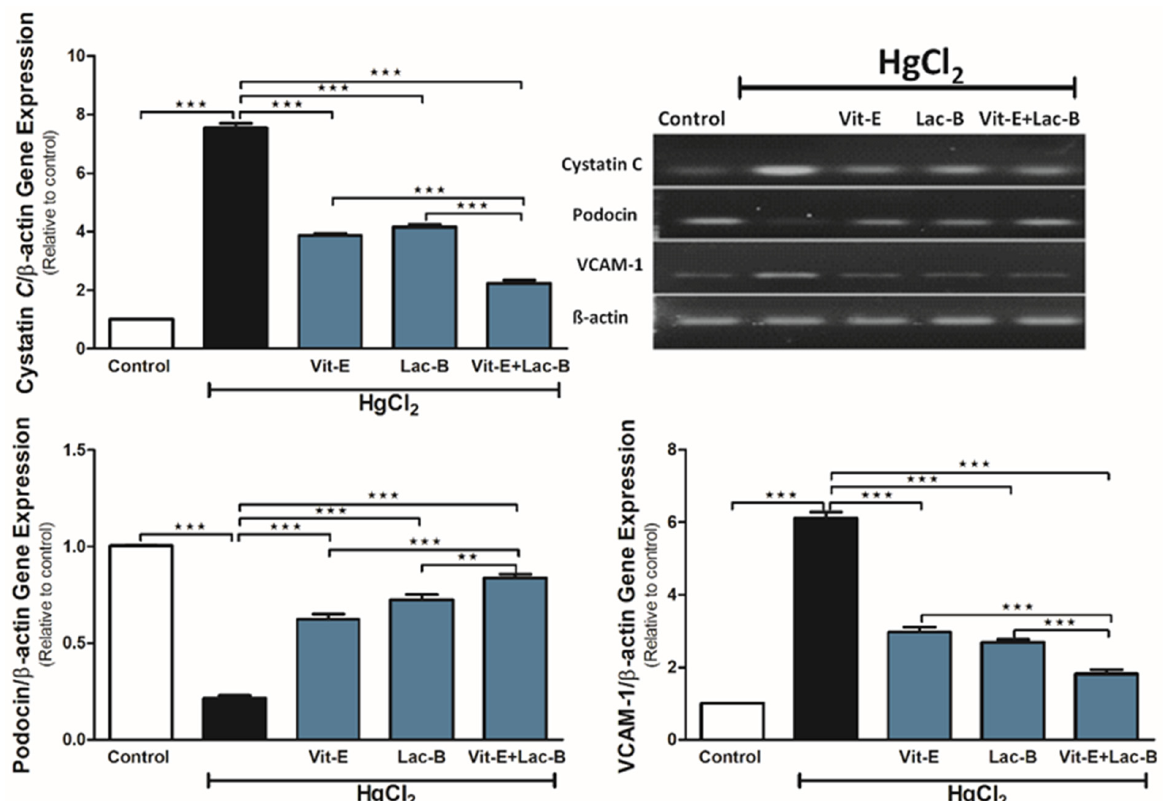
Figure 4. Vit-E and Lac-B suppressed renal cystatin C, VCAM-1 and increased podocin mRNA expression in HgCl 2 -intoxicated rats. Representative blots are showing variations in the expression of cystatin C, podocin, VCAM-1 and β -actin in all treated groups. Data were expressed as mean ± SEM, ( n = 6). ** p < 0.01 and *** p <